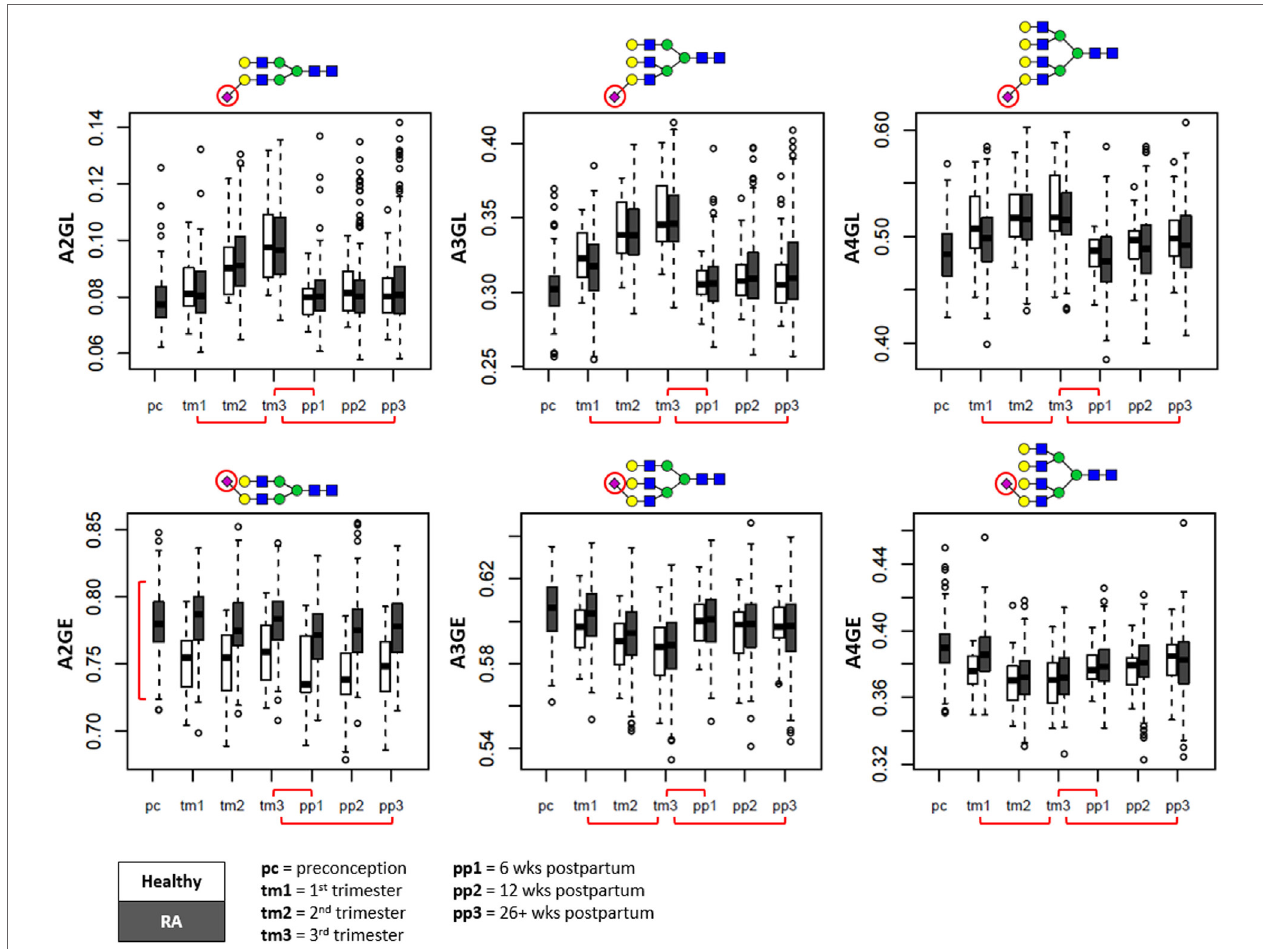
FigUre 4 | Sialylation changes throughout pregnancy and the postpartum period shown in boxplots. Whereas α 2,3-linked sialylation (L) displays the most prominent change throughout pregnancy ( top row ), α 2,6-linked sialylation shows the most distinction between patients and controls ( bottom row ). Separation is made between pregnancies of patients with rheumatoid arthritis (RA) (in gray) and healthy controls (in white). A2GL, α 2,3-linked sialylation per galactose of diantennary species; A3GL, α 2,3-linked sialylation per galactose of triantennary species; A4GL, α 2,3-linked sialylation per galactose of tetraantennary species; A2GE, α 2,6-linked sialylation per galactose of diantennary species; A3GE, α 2,6-linked sialylation per galactose of triantennary species; A4GE, α 2,6-linked sialylation per galactose of tetraantennary species. Red brackets indicate statistically significant findings between time points (horizontal), or between healthy individuals and RA patients